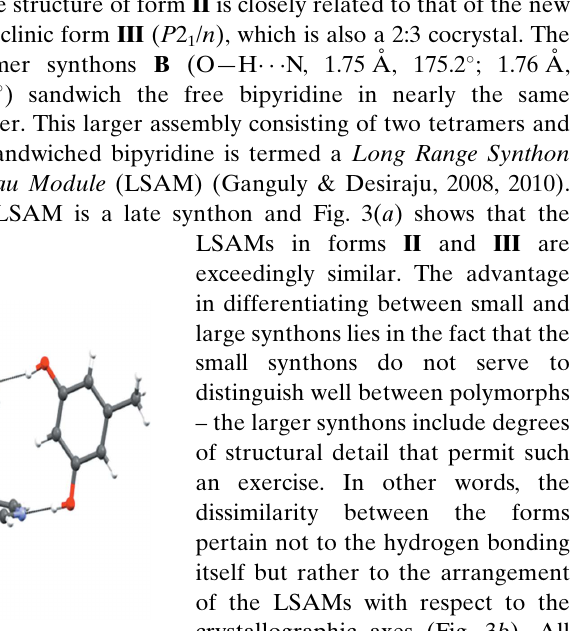
Figure 2 Divergent and convergent arrangement of O—H (cid:2)(cid:2)(cid:2) N hydrogen bonds in ( a ) form I (synthon A ), and ( b ) forms II – V (synthon B ) of orcinol:4,4 0 -bipyridine